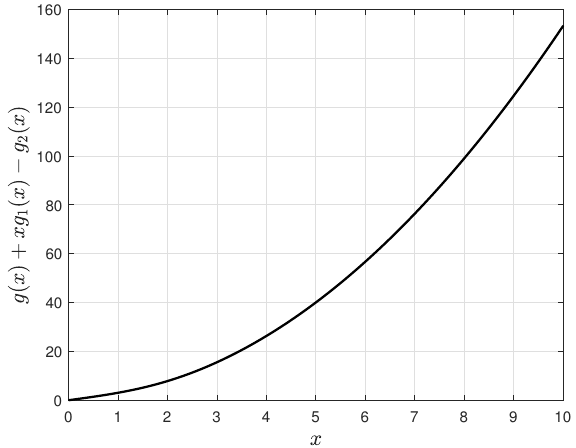
Figure 2. Verification for Lemma